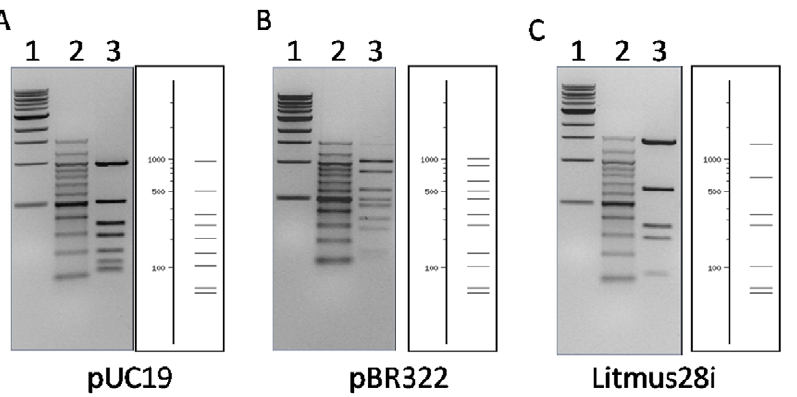
Figure 3. The digestion patterns of BtsI-1 on different substrates: 1 m l of BtsI-1B ( , 1.8 m M) was mixed with 1 m l of BtsIA and then digested 0.6 m g pUC19 (A), pBR322 (B) and Litmus28i (C) in NEB4 at 55 u C for 1 hour. In each figure, Lane 3 in the left panel is the actual digestion pattern and the right panel is the theoretical digestion pattern generated by NEBcutter V2.0. Lane 1: 1 Kb DNA Ladder (NEB # N3232); Lane 2: 100 bp DNA Ladder (NEB # N3231).